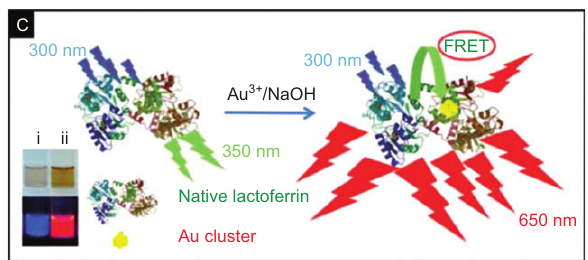
Figure 7 Schematic of the occurrence of FRET between Lf (NLf) and cluster. Inset shows the photographs of (i) NLf and (ii) Lactoferrin protected gold quantum clusters (AuQC@NLf) (from left to right) taken in visible light (above) and in UV light (below). From Ref. [87] .